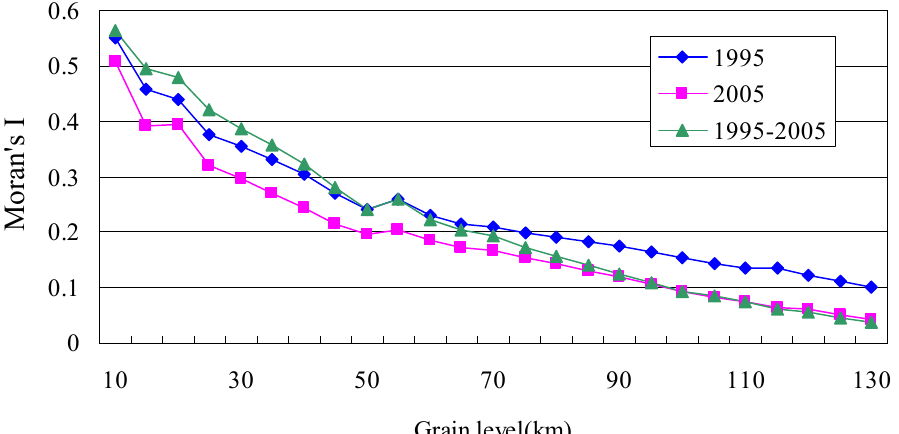
Figure 3. The response of Moran’s I for eco-risk to changes of grain